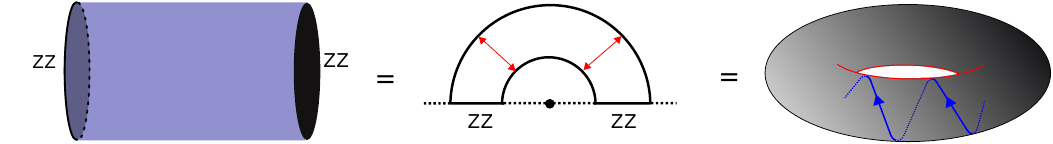
Figure 8 . Left: cylindrical surface bounded by ZZ-branes. Middle: the exponential map transforms this into an annular region in the upper half plane. The ZZ-branes are on the real axis and the semicircles are identi(cid:12)ed as shown. Right: performing the doubling trick (method of images) leads to a torus with only one